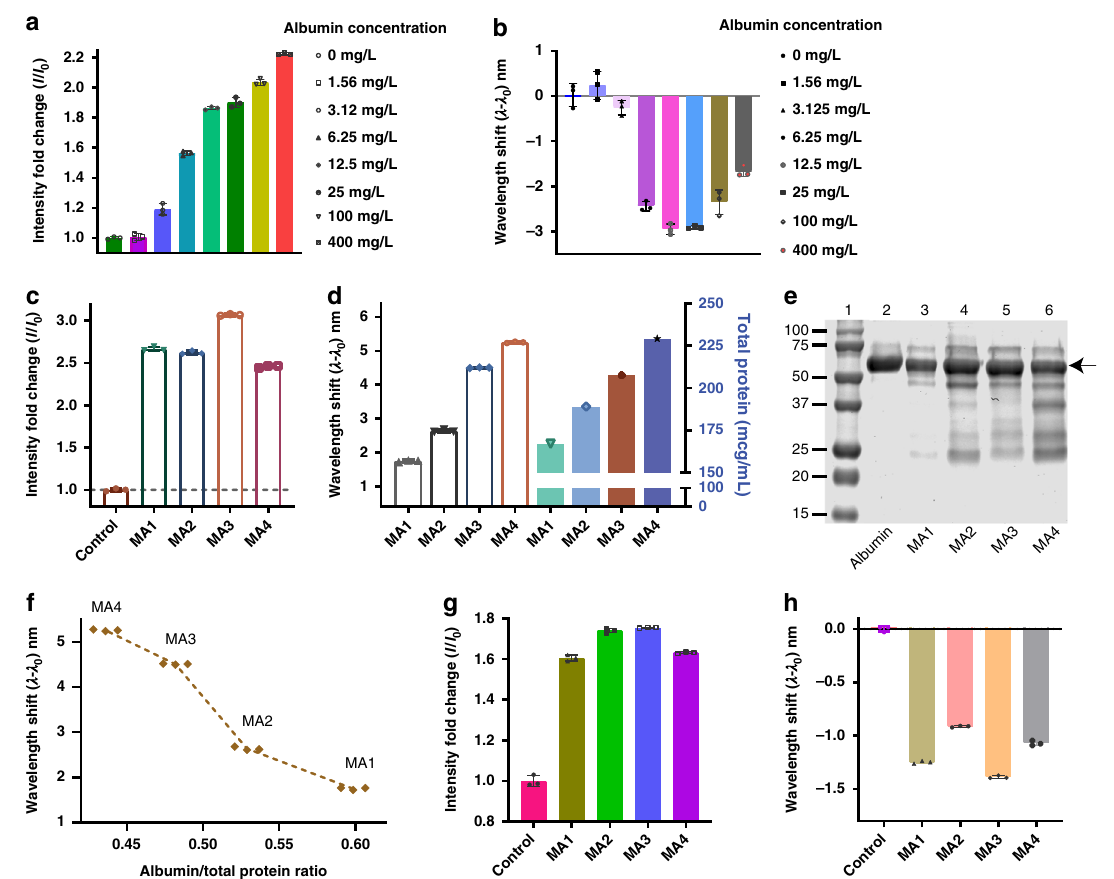
Fig. 3 Sensor response in healthy and microalbuminuria patient samples. a Nanosensor emission intensity response to albumin spiked into human urine. b Emission wavelength response of the nanosensor to albumin in human urine. c Emission intensity response of the nanosensor to microalbuminuria patient samples. d Emission wavelength response of the nanosensor to microalbuminuria patient samples (left) and total protein determined via turbidimetry assay (right). e SDS-PAGE gel showing protein bands on microalbuminuria patient urine samples: (lane 1) molecular weight marker, (lane 2) albumin control, (lanes 3 – 6) microalbuminuria urine samples; arrow indicates albumin band. f Wavelength shift response from the nanosensor to total protein ratio in microalbuminuria urine samples. g Emission intensity response of the nanosensor to microalbuminuria urine samples after removal of interfering proteins. h Wavelength response of the nanosensor to microalbuminuria urine samples after removal of interfering proteins. The data presented in Fig 3a – h show the response of the (9,4) nanotube chirality. Error bars represent standard deviation for n = 3 technical